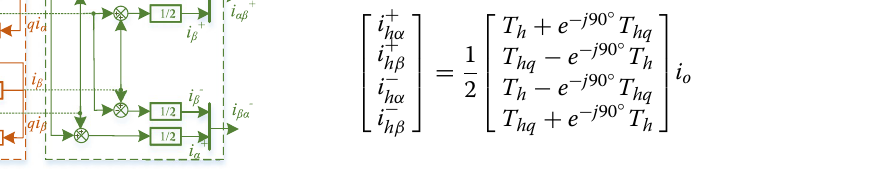
Fig. 4 Block diagram of the current signal extraction